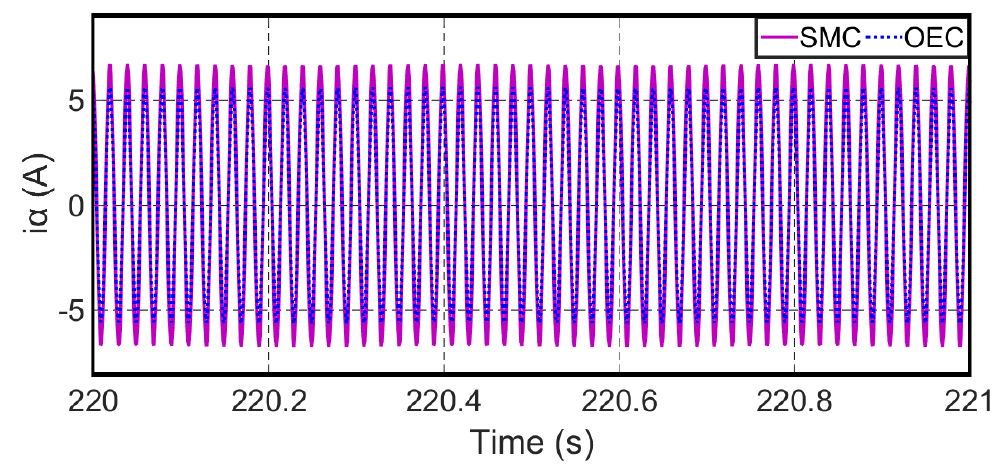
Figure 13. Experimental analysis: EV powertrain